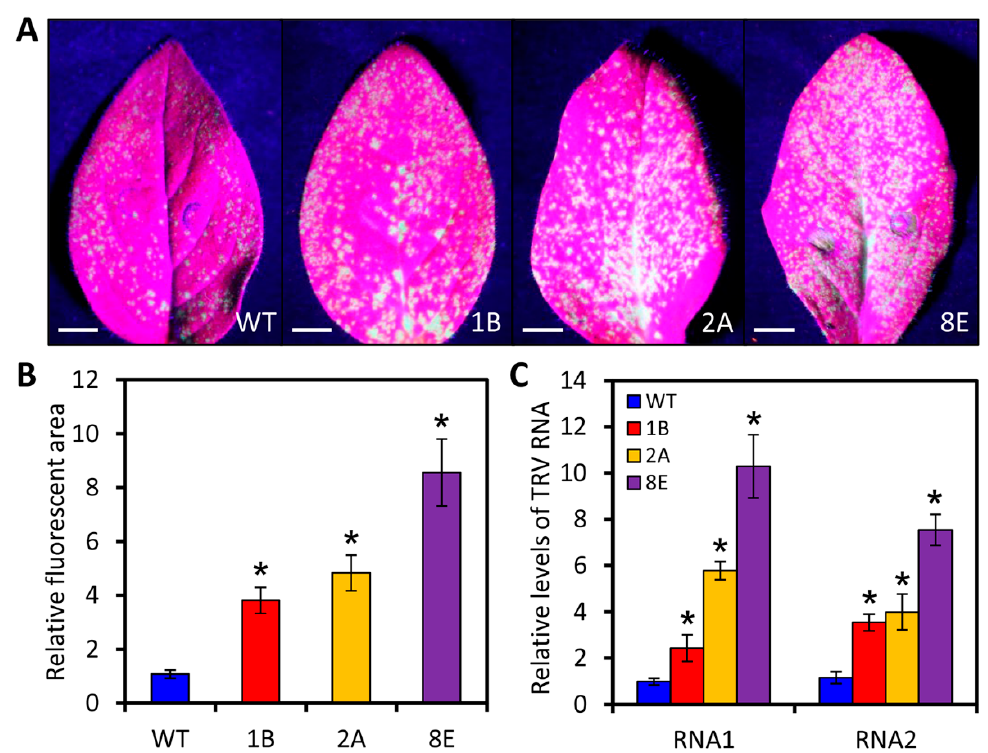
Figure 6. Increased accumulation of tobacco rattle virus-green fluorescent protein (TRV-GFP) in LreEF1A4 -overexpressing transgenic petunia plants. GFP fluorescence ( A ) and relative fluorescent area ( B ) in TRV-GFP-inoculated leaves of wild-type (WT) and transgenic lines (1B, 2A, and 8E). Photographs were taken at 4 days post inoculation (DPI). Scale bars = 5.0 mm. ( C ) Quantitative real-time polymerase chain reaction (PCR) analysis of TRV RNA1 and RNA2 accumulation levels in the leaves of WT and transgenic petunia plants at 4 DPI. Abundance of 26S rRNA transcripts was used as an internal control. Error bars represent standard error (SE) of the mean from three independent biological replicates. Significance of difference was evaluated via Student’s t -test ( p < 0.05) and denoted by asterisks.